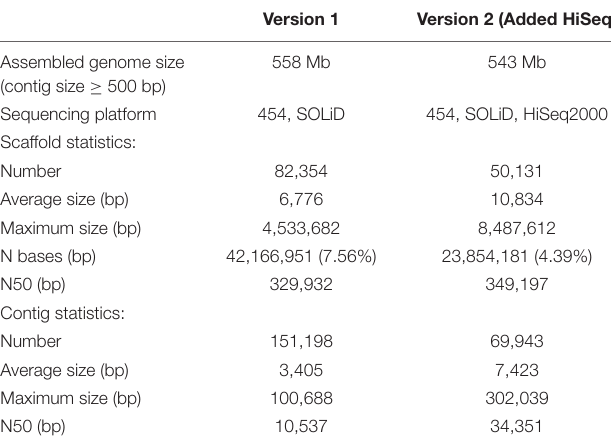
TABLE 2 | Comparison of the version 1 and version 2 date palm genome assembly.